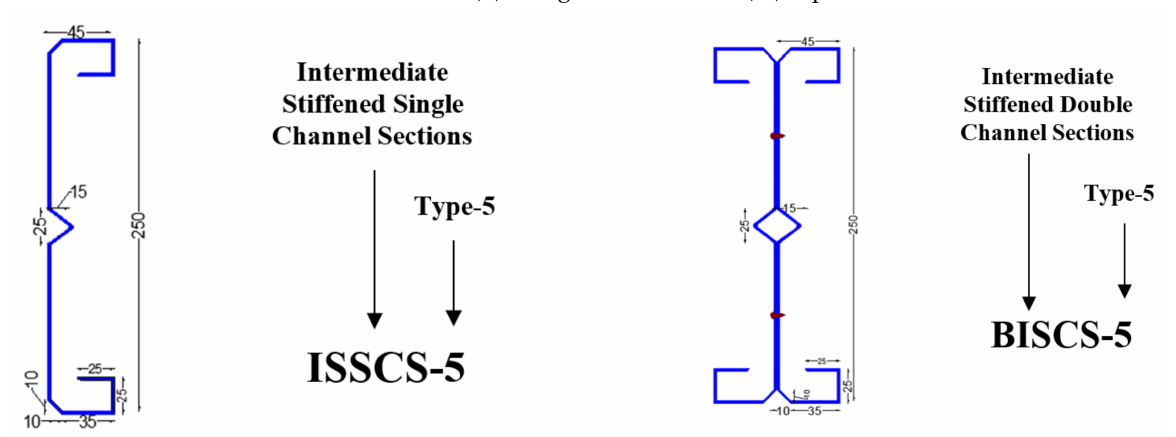
Figure 5. Specimen labelling for the experimental